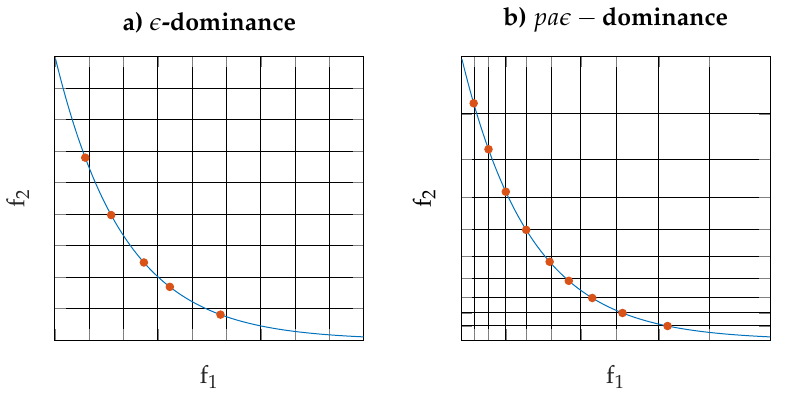
Figure 4. Example of assignment of a group of solutions of the bi-objective problem to corresponding Pareto fronts in accordance with the definition of (cid:101) -dominance. Points x 5 oraz x 9 lie in the same square. Therefore, the fact that x 5 (cid:31) x 9 is determined by their distance from point d ( d 1 < d 2 ) [40].